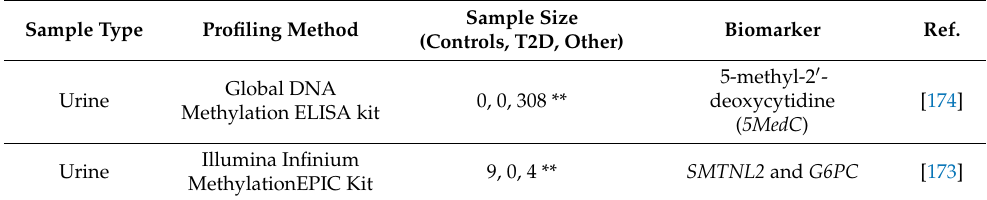
Table 9. DNA methylation biomarkers from urine samples for T2D.